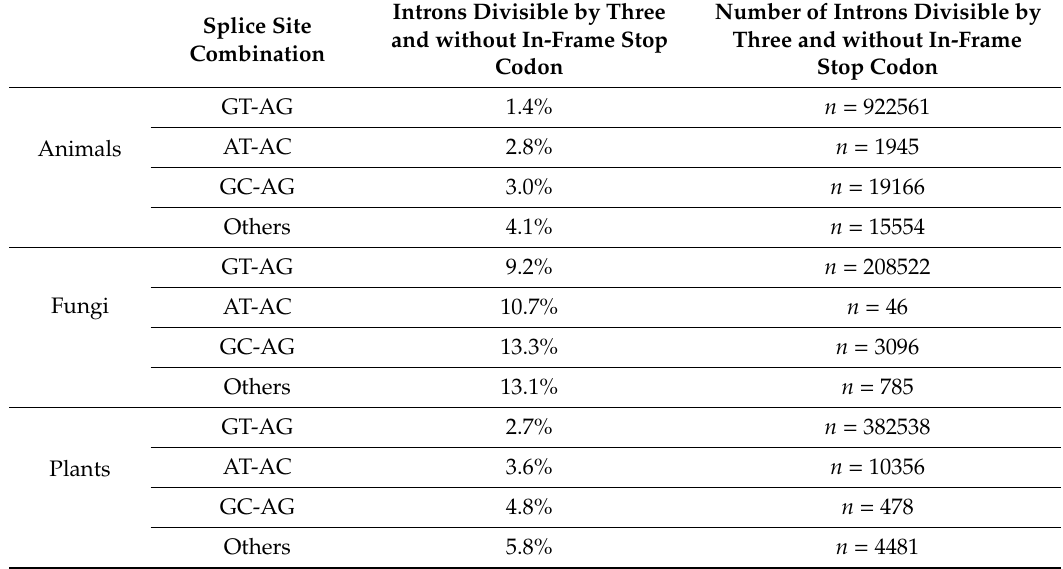
Table 2. Proportion of introns with a length divisible by three and without an in-frame stop codon. The results of intron length analysis for selected splice site combinations for animals, fungi, and plants are